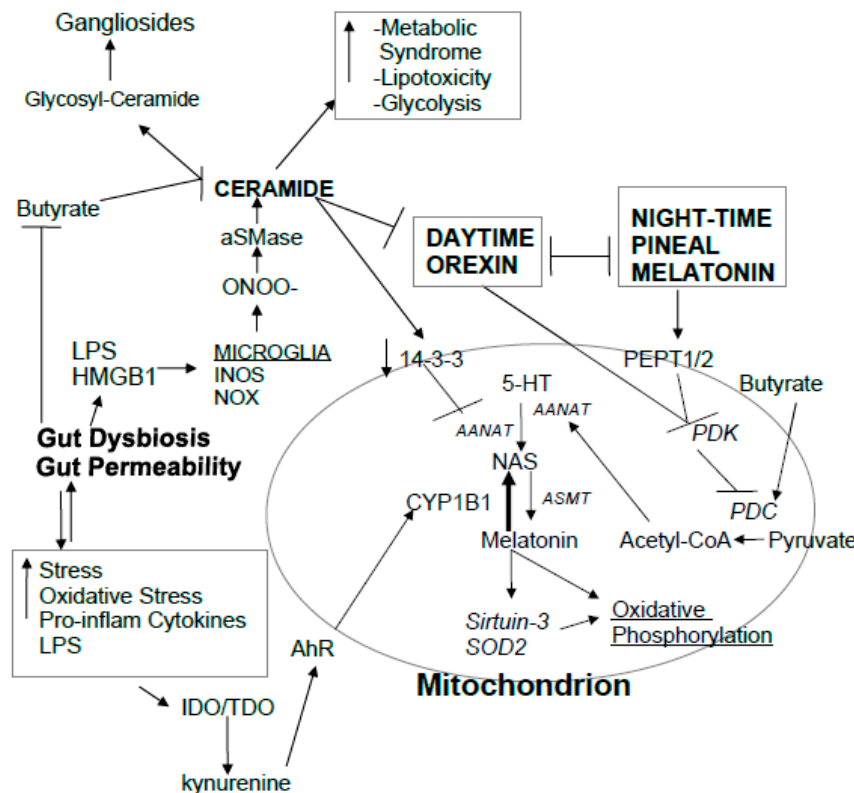
Figure 1. Gut dysbiosis / permeability increase circulating LPS and exosomal HMGB1, leading to TLR activation in microglia and the induction of iNOS and superoxide. This leads to the formation of ONOO - , which is a major inducer of aSMase and ceramide. Ceramide has negative impacts on mitochondria functioning, both directly and via the inhibition of orexin and melatonin. Orexin, melatonin, and butyrate disinhibit PDC, leading to an increased conversion of pyruvate to acetyl-CoA, which is the necessary co-substrate for AANAT and the initiation of the mitochondria melatonergic pathway. Increased mitochondria melatonin promotes SOD2, sirtuin-3, and oxidative phosphorylation. By decreasing cellular 14–3-3, ceramide may also inhibit the stabilization of AANAT, thereby preventing the initiation of the melatonergic pathway. Ceramide also increases metabolic syndrome, lipid dysregulation, and gluconeogenesis, all of which are more evident in MS. Gut dysbiosis / permeability have reciprocal interactions with stress, cytokines, and oxidative stress, which can all increase IDO and TDO, leading to kynurenine, which activates the AhR and increases CYP1b1, leading to the backward conversion of melatonin to NAS. Gut dysbiosis / permeability lowers butyrate levels, thereby decreasing butyrate’s suppression of ceramide. Butyrate drives the conversion of ceramide to glucosylceramide and the MS-protective gangliosides. The decrease in butyrate attenuates its inhibition of glia and immune cell reactivity, likely mediated via butyrate regulation of the mitochondrial melatonergic